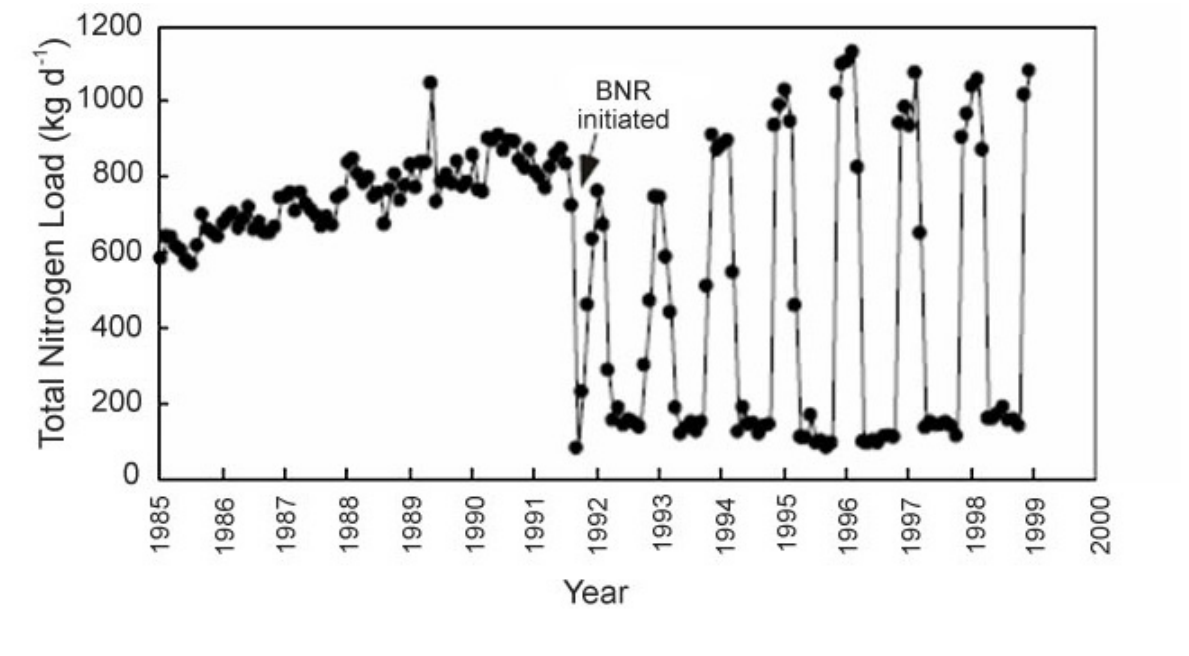
Fig. 7. Patterns in total nitrogen point source loads in the Patuxent River (adapted from Boynton et al. 2008). Significant reductions in sewage treatment plant discharges occurred following the 1991 initiation of biological nitrogen removal (BNR) during warm-weather months (April–October). Recent increases in loads are due predominantly to expansion of residential hook-ups to sewage treatment plant